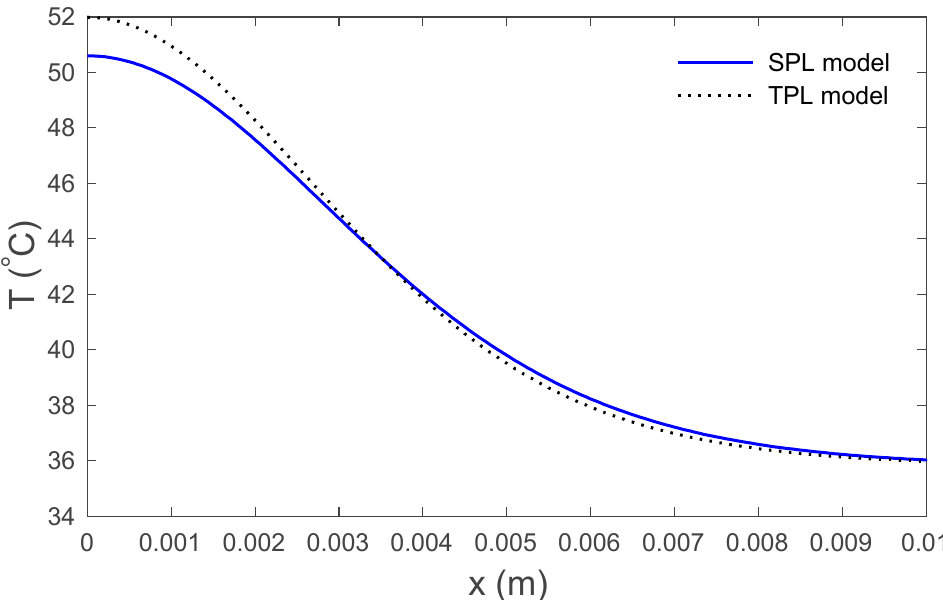
Figure 2. Variations in temperature versus the distance for the SPL and the TPL